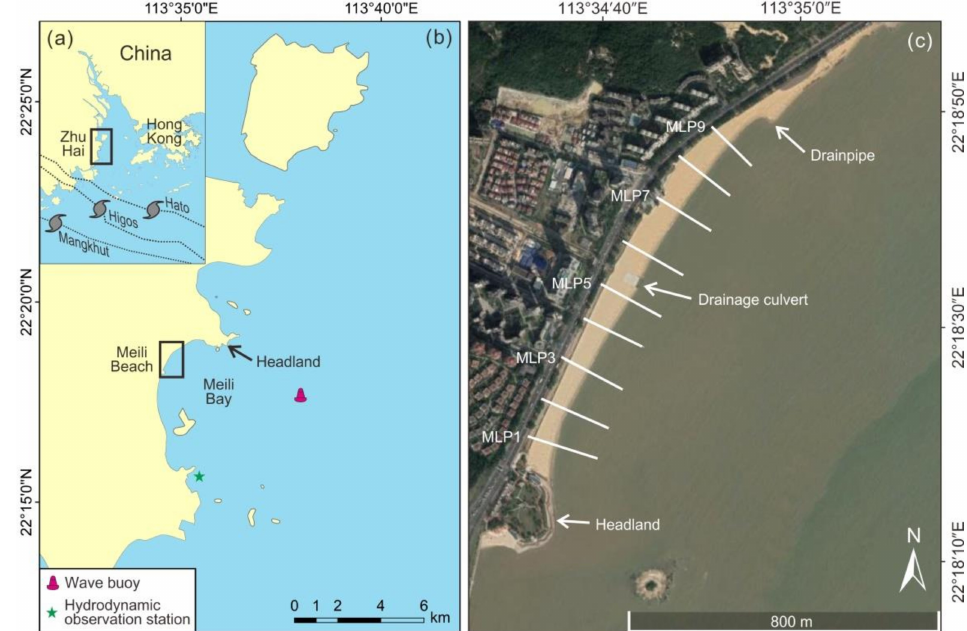
Figure 1. Location map of Meili (ML) beach and associated beach profiles. The dotted lines in ( a ) indicate the tracks of three energetic typhoons affecting this beach since 2016. The locations of the wave buoy and hydrodynamic observation station are showed in ( b ), whereas the white lines in ( c ) indicate the monitored beach profiles. The image in ( c ) is from Google Earth, taken in February 2019.